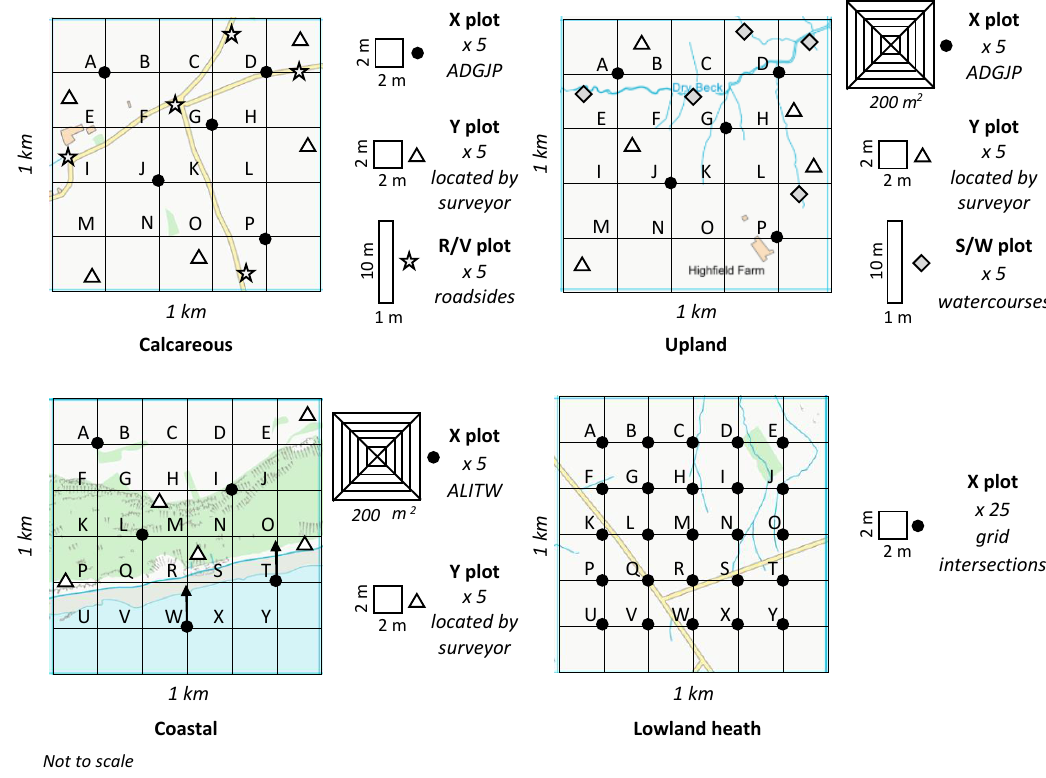
Not to scale Contains OS data © Crown copyright and database right (2018) Figure 2. Gridded sampling structure for 1km survey squares. Vegetation plots were recorded as shown, with land cover and boundary features being recorded at every grid intersection point in each